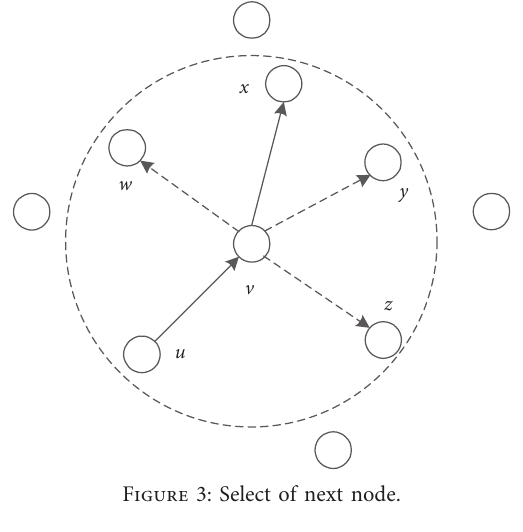
Figure 3: Select of next node.